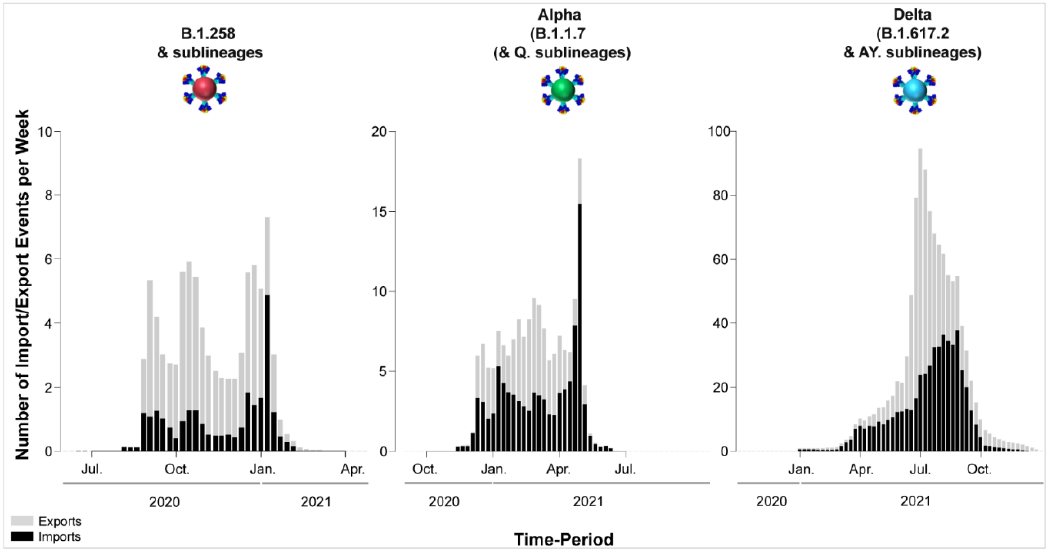
Figure 10. Temporal dynamics of SARS-CoV-2 export and import from and to Cyprus. The width of each column corresponds to one week, and the height corresponds to the mean of the estimated total number of migration events (to/from Cyprus) inferred to have occurred in that week. Exports are shown in gray columns; imports are shown in black columns. The y-axis represents the number of import/export events per week; the x-axis represents time.